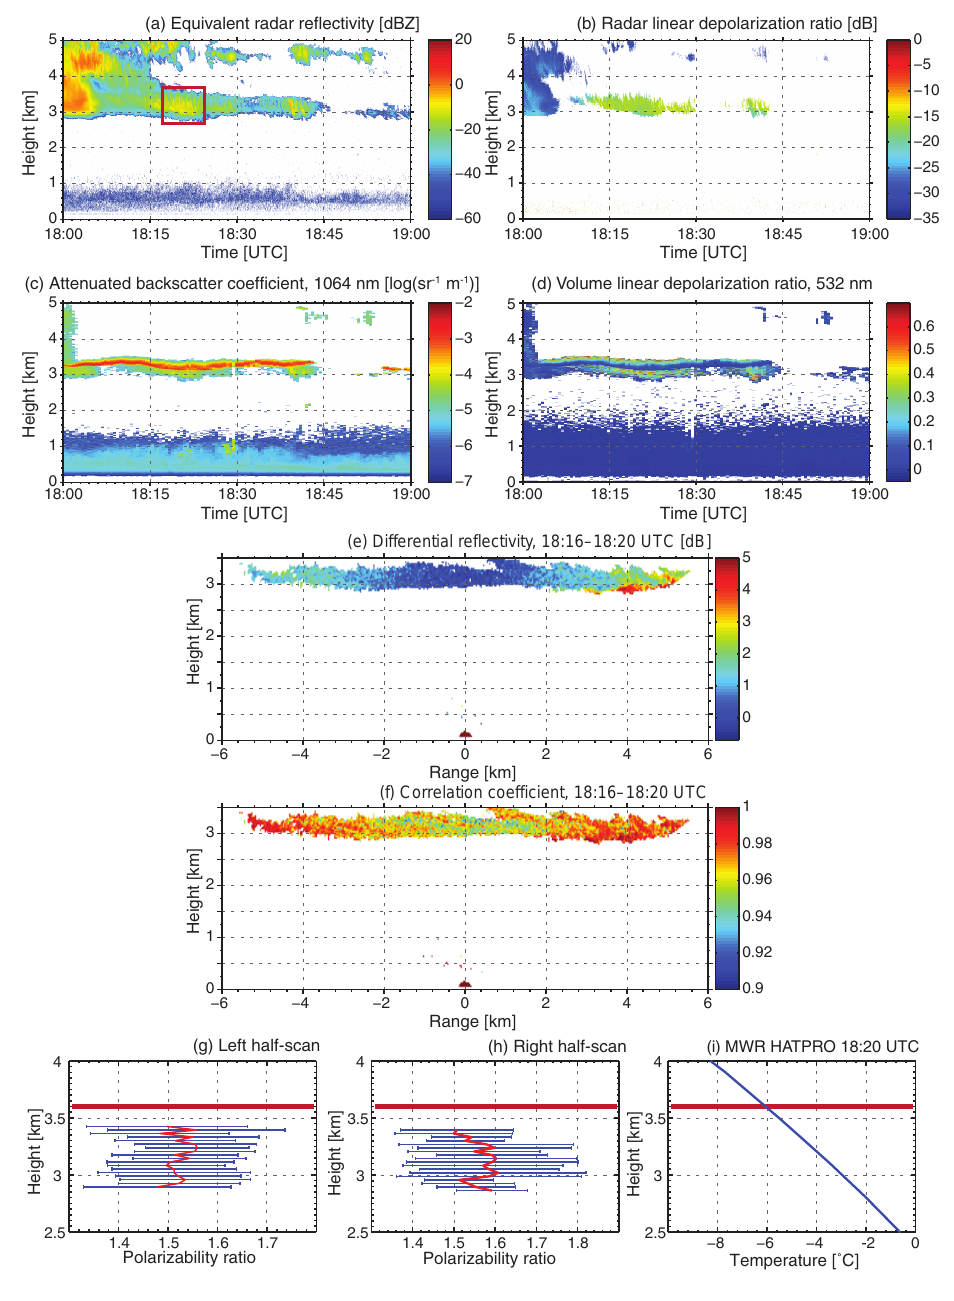
Figure 5. Same as in Fig. 3 but for 20 October 2014 and without a photograph.